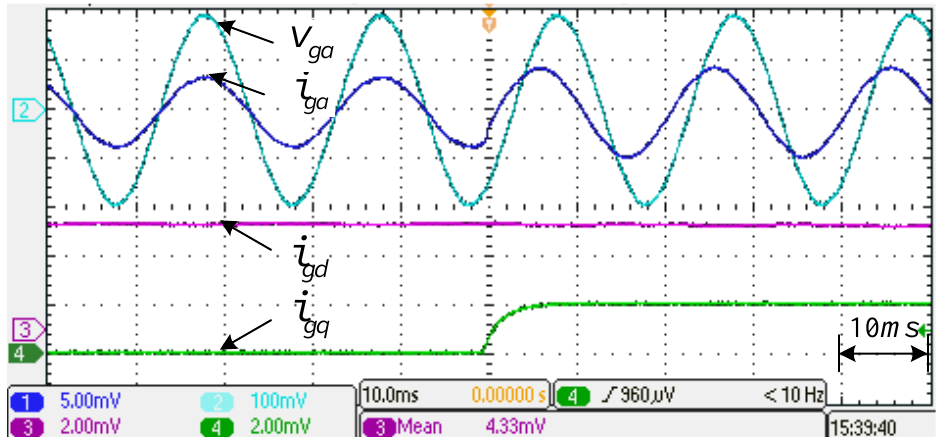
Figure 17. Grid-injected current control, i ga the grid current of phase A (5 A/div), v ga the grid voltage of phase A (100 V/div), i gq the reactive current (2 A/div), i gd the active current (2